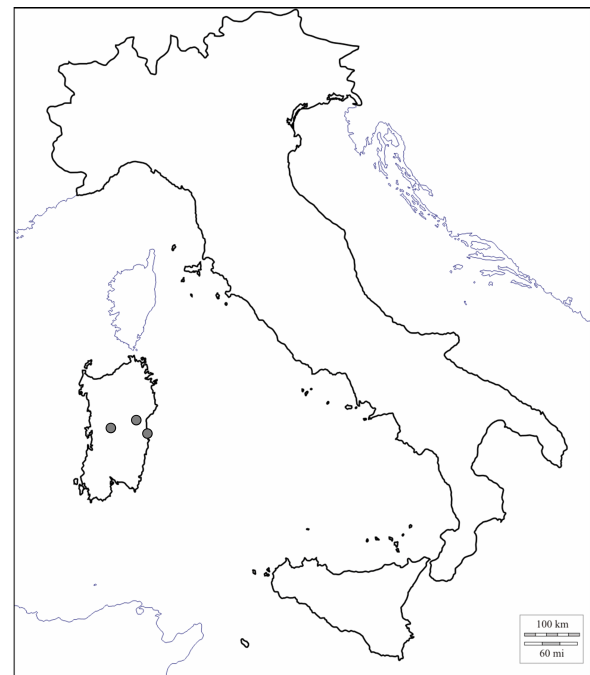
Figure 8. Distribution map of Plecotus sardus (data from Mucedda et al. 2002).